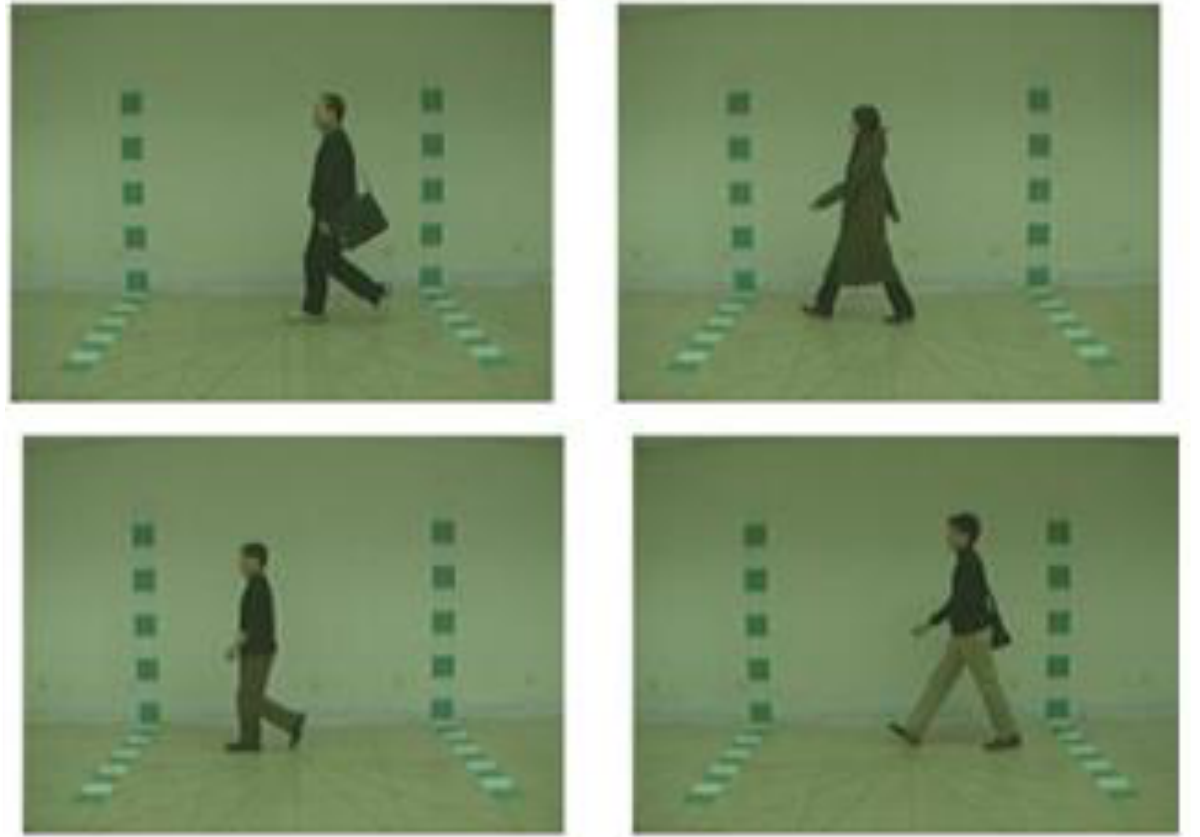
Figure 7. Sample frames collected from CASIA B dataset [44].